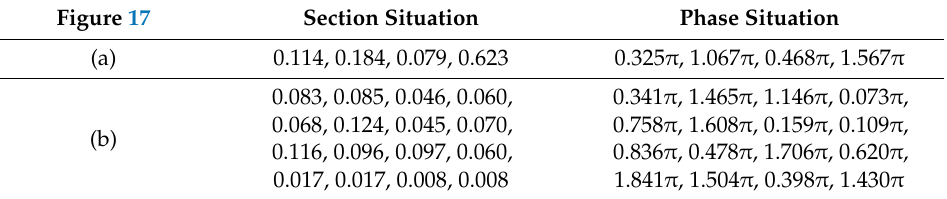
Table 10. Parameter settings of MPSM jamming with optimized phase situation.